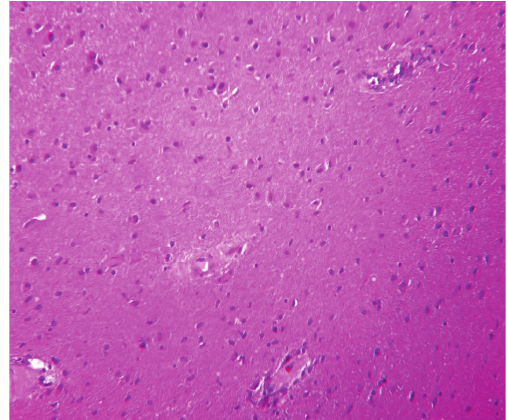
Figure 2: Postchemotherapy histology: mature glial tissue (hema- toxylin and eosin stain ×